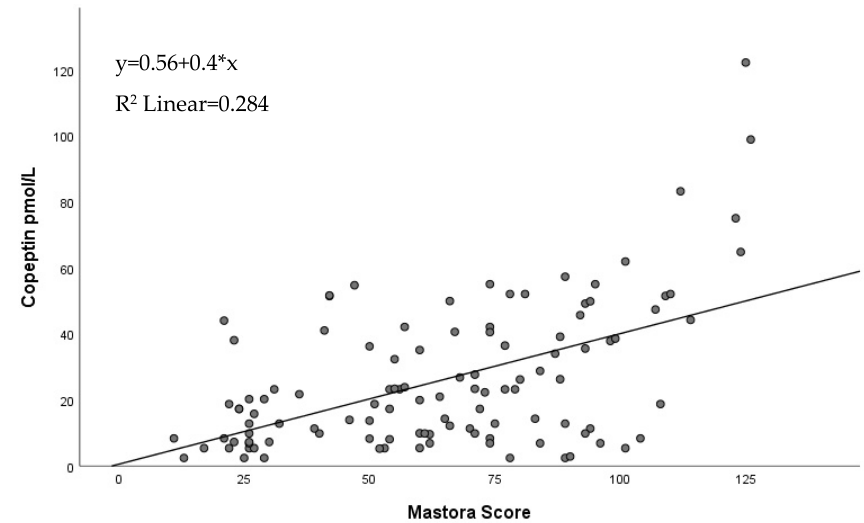
Figure 3. Linear regression between Mastora score and copeptin .